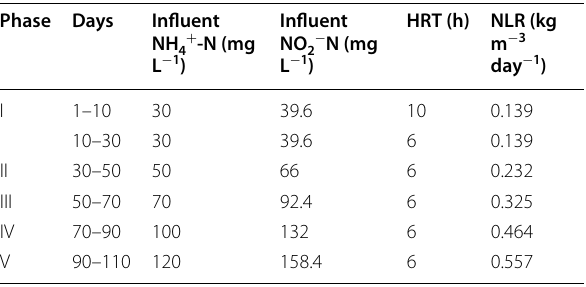
HRT Hydraulic retention